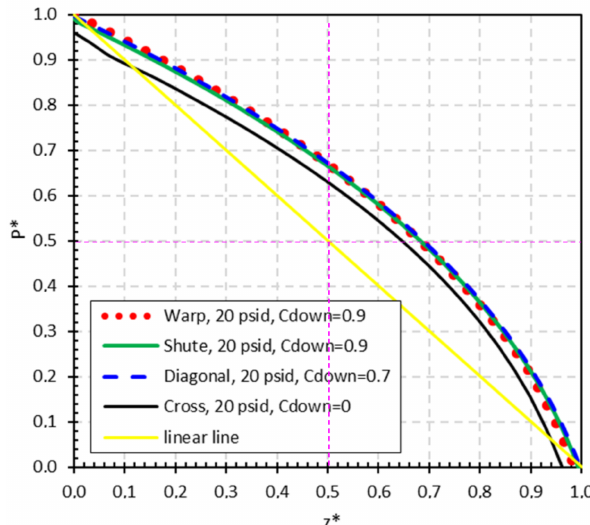
Figure 18. Normalized pressure within the porous metallic-cloth fibers in the flow direction (normalized weave thickness (z*) vs. normalized pressure